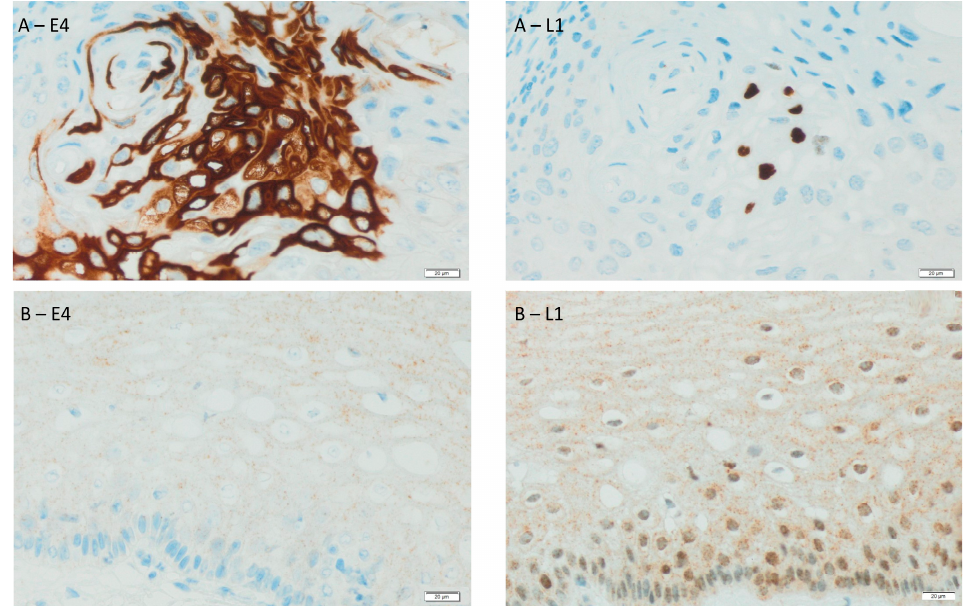
Figure 1. Immunohistochemical expression of HPV in epithelial cells in the tissue of the same patients ( A , B ). Detection was observed using antibody Ab-3 (clone K1H8) detected major HPV capsid protein L1 and E4 SILgrade-E4 (XR-E4-1) detected E4, a protein marker for initiation of a productive phase of the HPV life cycle. The brown colour indicates an immunopositive immunohistochemical reaction for the tested markers. Magnification 400×.